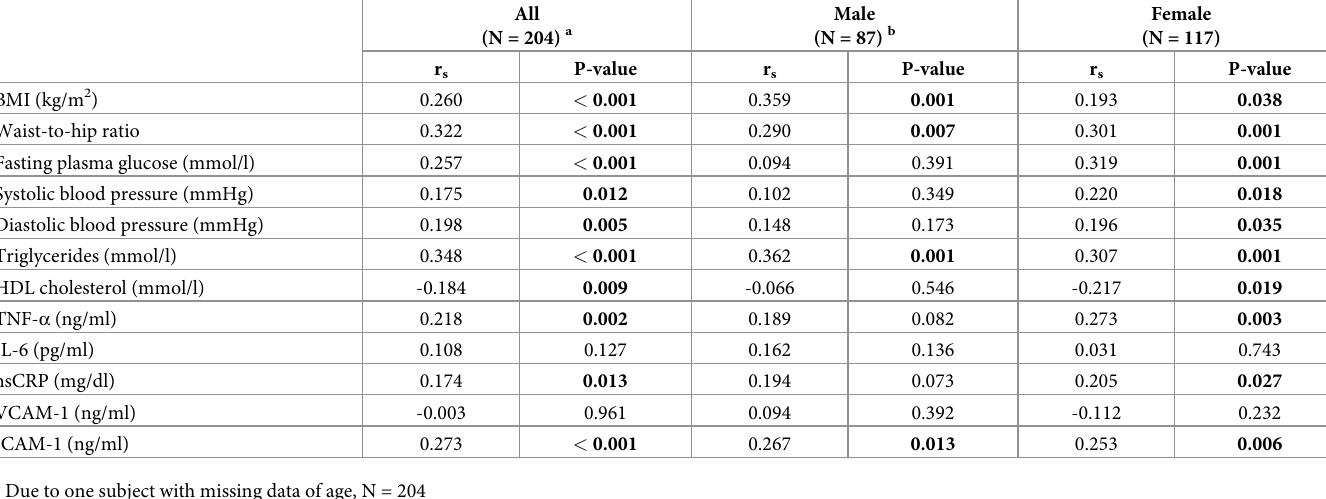
Table 3. Age-adjusted Spearman partial correlation coefficients between E-selectin concentration and anthropometric (BMI, waist-to-hip ratio) and biochemical variables by gender.